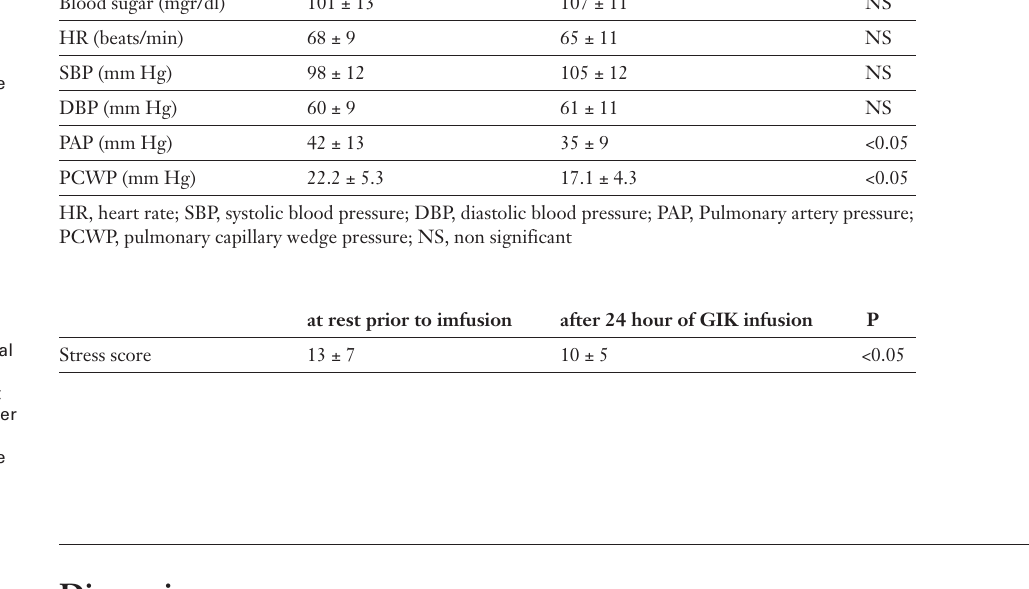
Haemodynamic parameters at rest before and after 24 hour of GIK- infusion (values are mean ± S.D.)